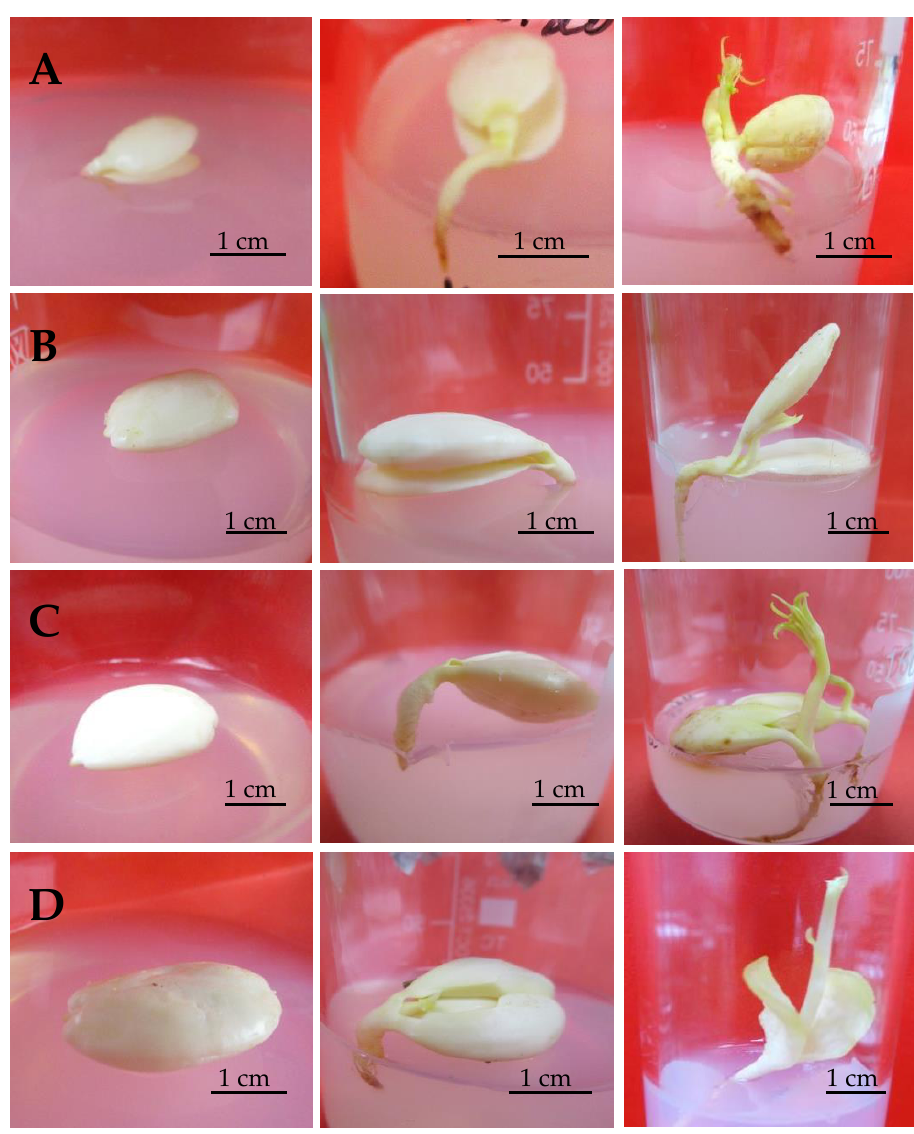
Figure 1. Germination of peach hybrid embryos on Monnier culture medium: ( A ) ‘Clyde Wilson’ × ‘Nikitskiy Podarok’, ( B ) ‘Jerseyglo’ × ‘Nikitskiy Podarok’, ( C ) ‘Loadel’ × ‘Nikitskiy Podarok’, ( D ) ‘Summerglo’ × ‘Nikitskiy